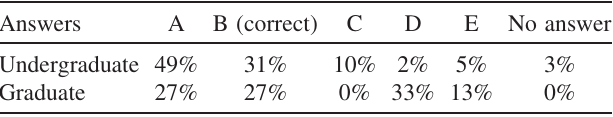
TABLE III. The choice distributions of 61 undergraduate stu- dents and 15 graduate students answering the question about energy measurement